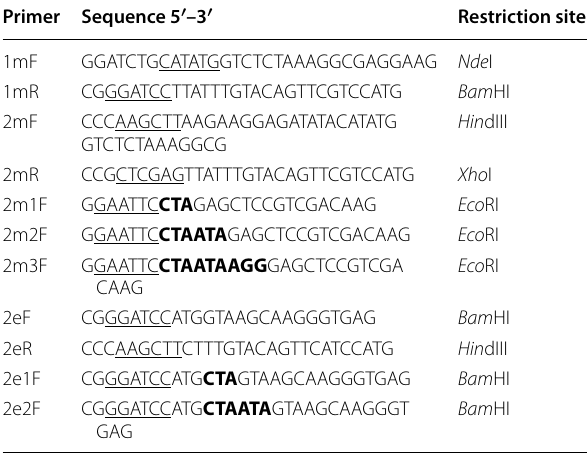
Rare codons are represented in bold, and restriction enzyme sites are indicated with underline